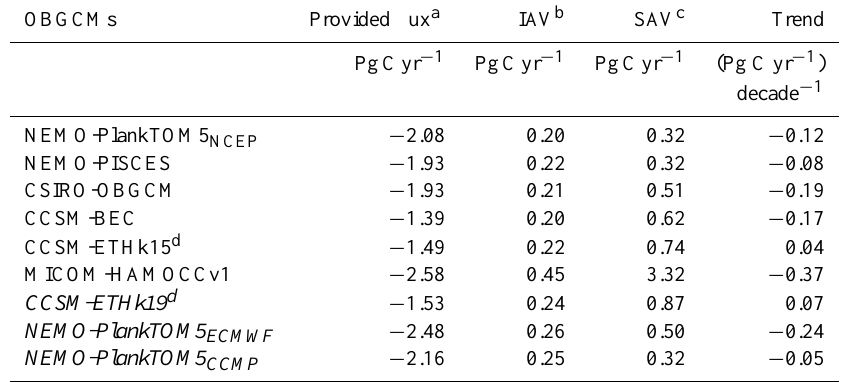
Table 4. Comparison of sea–air anthropogenic CO 2 flux, interannual and subannual variability of individual OBGCM outputs used. OBGCMs